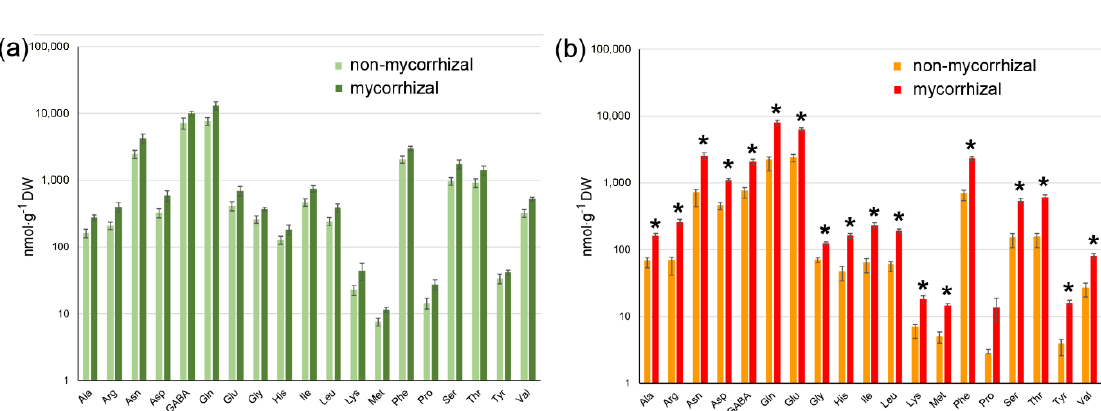
Figure 5. Levels of amino acids in green ( a ) and red ( b ) fruits of non-mycorrhizal and mycorrhizal tomato plants. Amino acids were determined by HPLC using methanol extracts from freeze-dried material. Note that there are no significant differences in the contents of any amino acids in green fruits, whereas all levels except that of proline were increased in red fruits upon mycorrhization of plants. Data are given as means ± SE ( n = 8). * marks significant differences ( p < 0.05) between fruits from non-mycorrhizal and mycorrhizal plants according to 1-factorial ANOVA including Bonferroni correction.